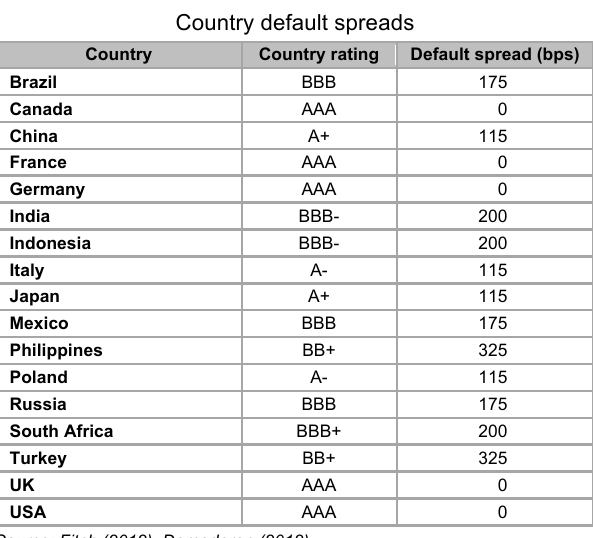
Country Country